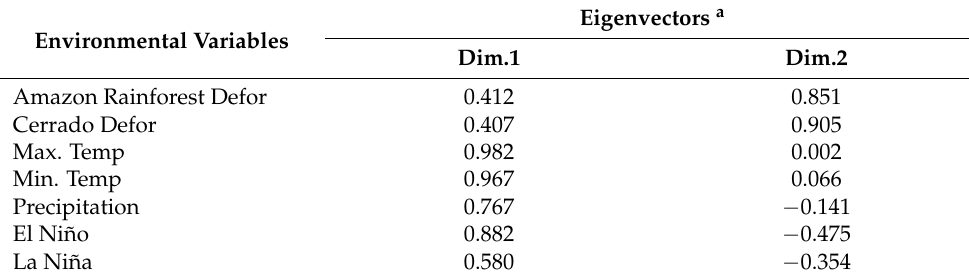
Table 1. Importance of environmental variables for the cases of DENV.